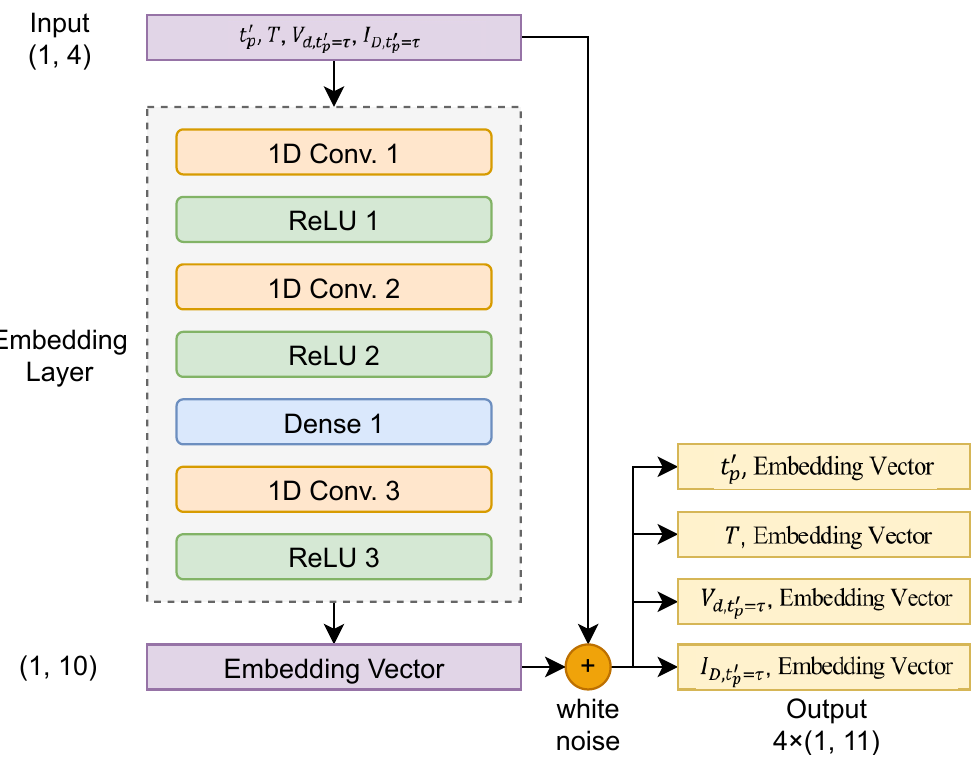
Figure 4. Overview of proposed deep-feature generation